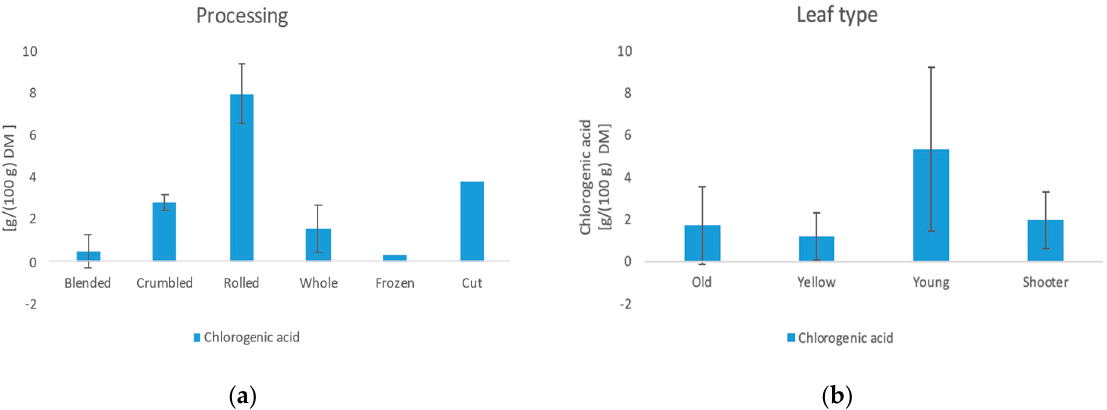
Figure 8. ( a ) Influence of the processing method on the chlorogenic acid content. ( b ) Influence of the leaf type on the chlorogenic acid content.